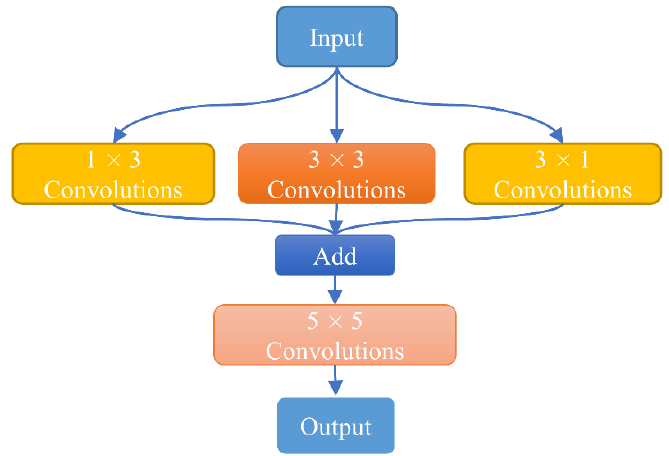
Figure 5. Structure of the ACE module.